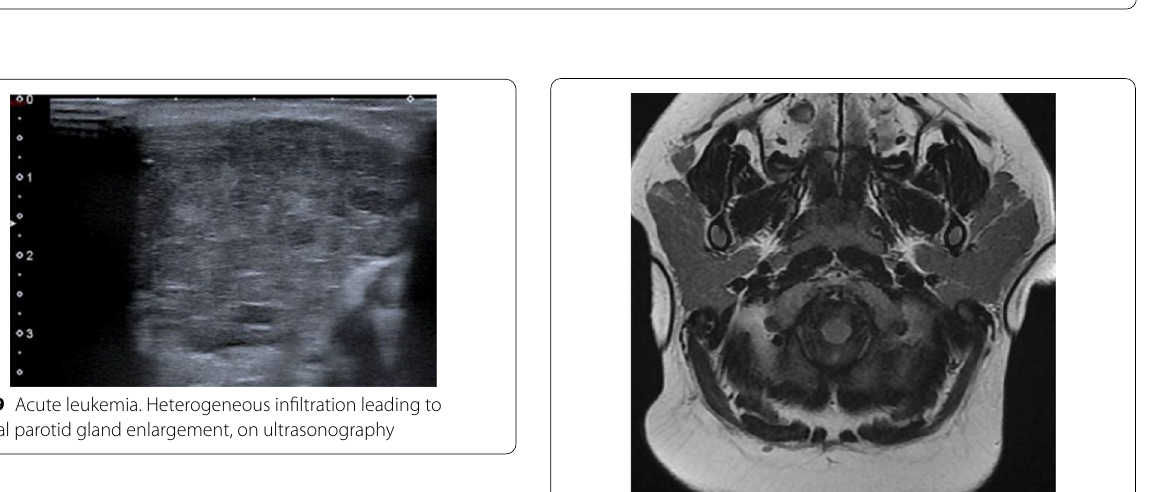
Fig. 18 Embryonic rhabdomyosarcoma. Heterogeneous structure and vascularization on B‑mode sonography and color Doppler ( a and b ), large at the time of diagnosis on frontal T 2 ‑weighted image ( c )